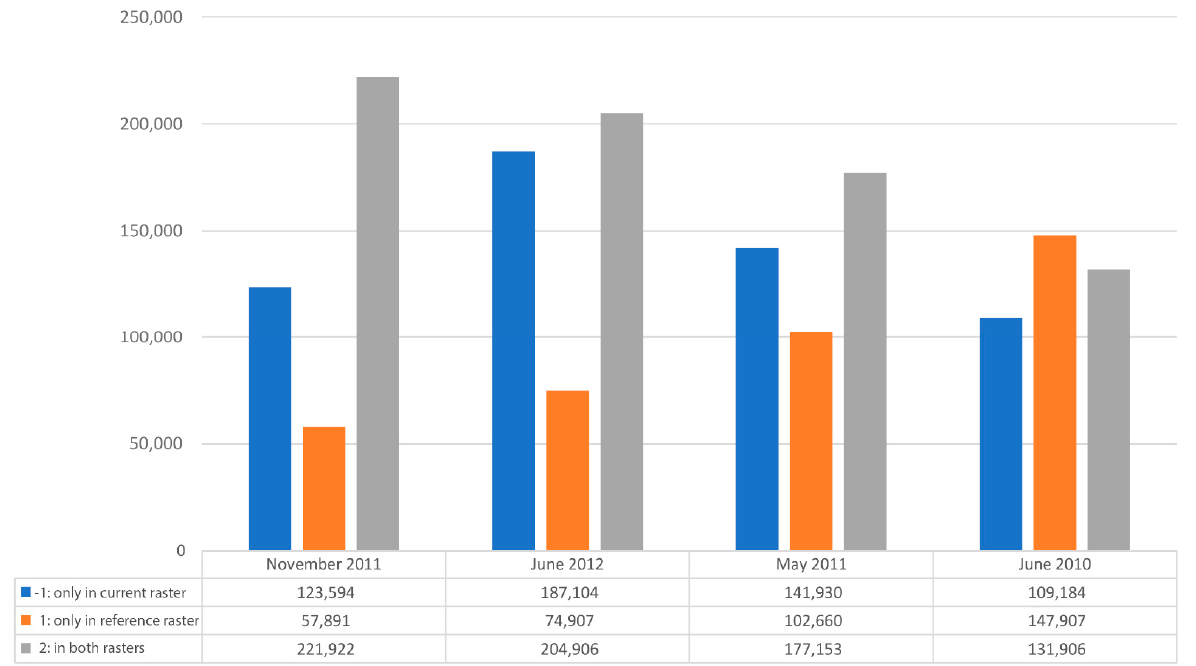
Figure 16. Summed up results of mutual comparison of Spring 2007 interpretation and results derived from the other datasets for all sample zones.